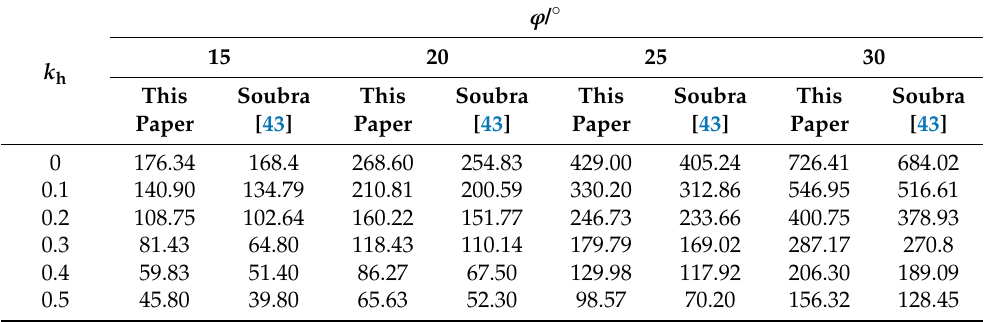
Table 2. Values of seismic bearing capacity p ce